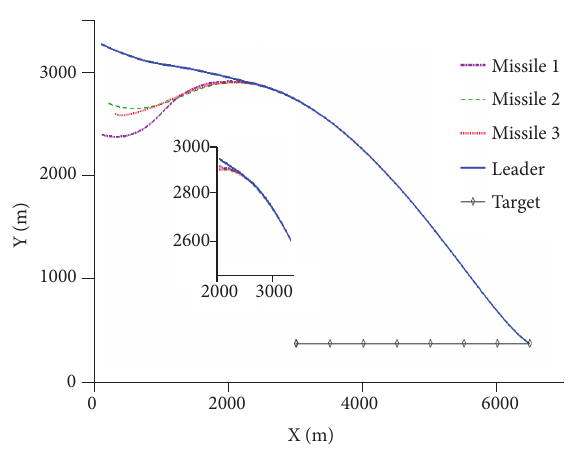
Figure 3. Trajectories of the interceptors and target obtained using the improved cooperative control strategy.